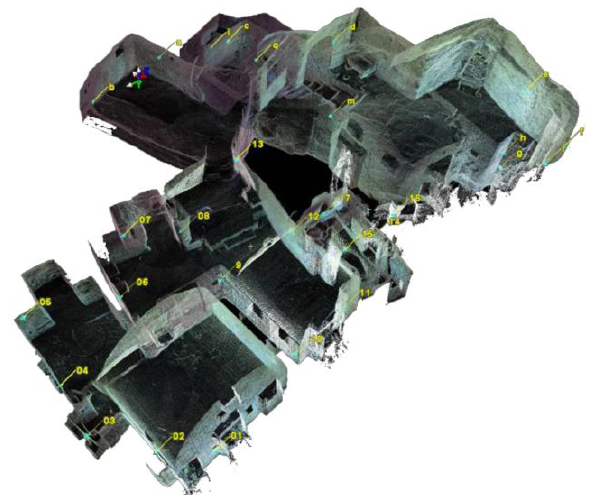
Figure 6. Identification and positioning of the targets